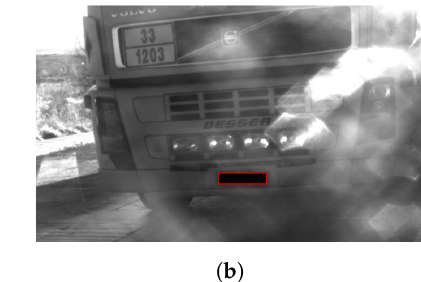
Figure 5. Erroneous detection outputs from toll posts cameras. ( a ) Photo of the second worst example of what is a large vehicle (truck, bus, other non-car or motorcycle), with no other usable details. ( b ) Snow is covering almost the entire camera lens of what is also apparently a large vehicle (truck, bus, other non-car or motorcycle).